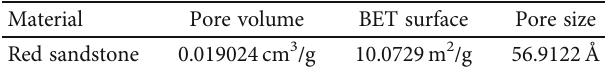
Figure 2: XRD image of GO, red sandstone, and GO/red sandstone. Table 2: Red sandstone-speci fi c surface area, pore size, and